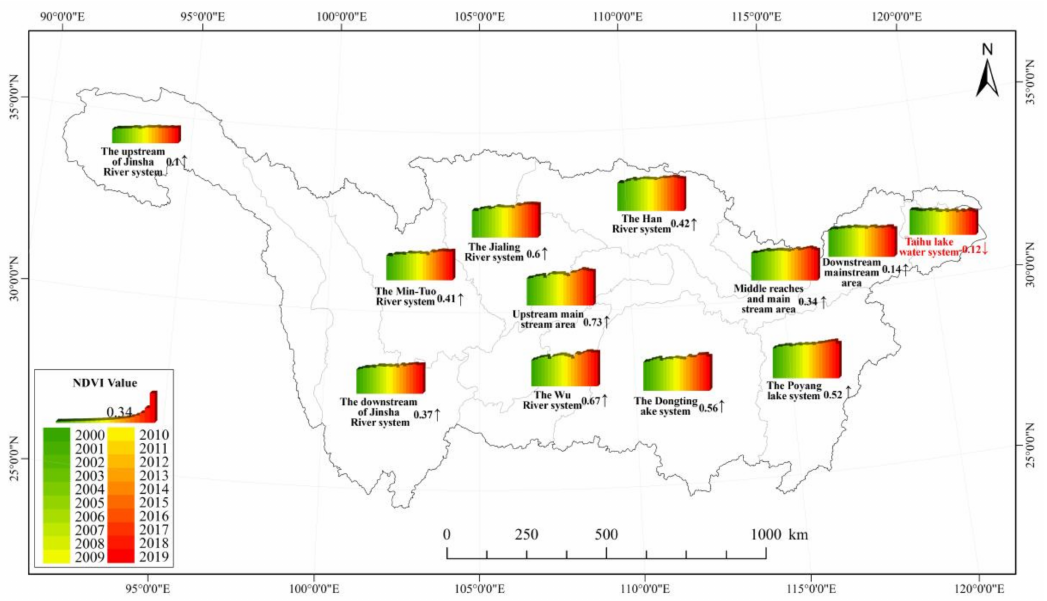
Figure 4. Interannual variation of NDVI in each sub-basin of the Yangtze River Basin